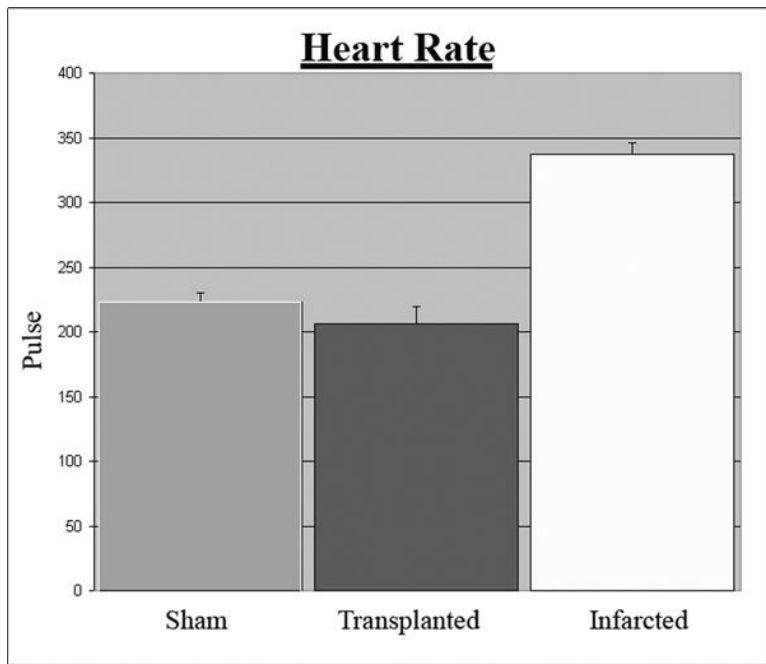
FIGURE 3. Comparison of basic cardiac physiology. Transplantation of olfactory neurosphere-derived cells led to restoration of normal resting heart rate after myocardial infarct. The infarct alone group differed significantly from the transplanted and sham groups using ANOVA ( p ≤